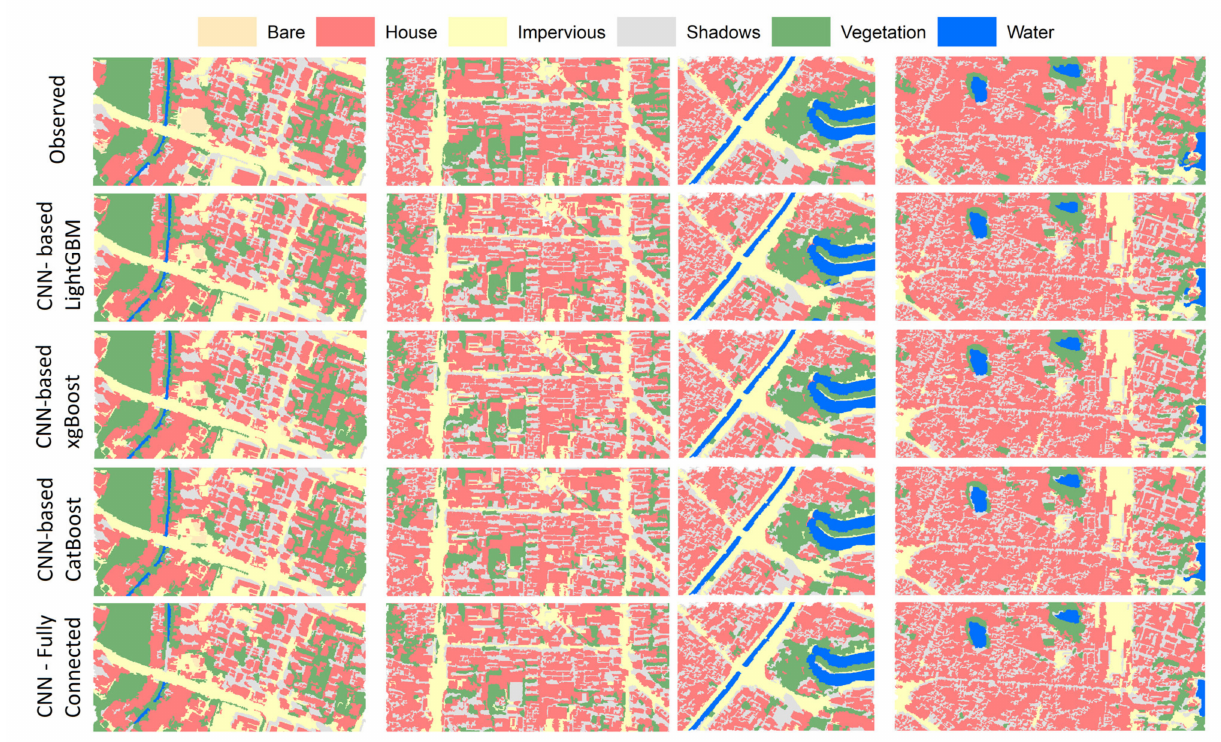
Figure 7. Classification results from different CNN-based